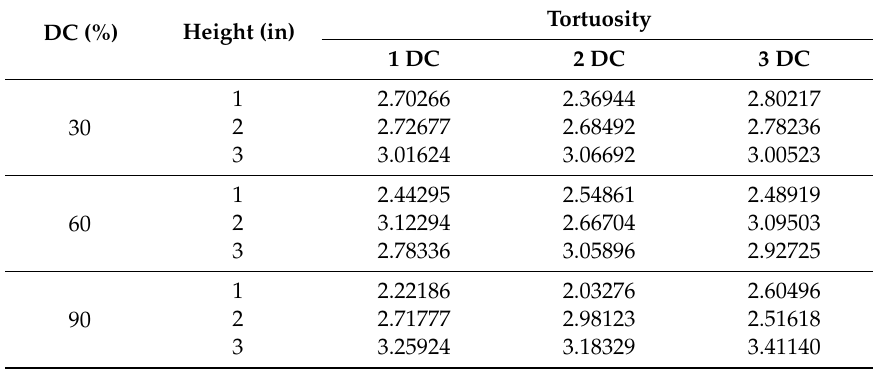
Table 4. Results of tortuosity at di ff erent dynamic compressions.